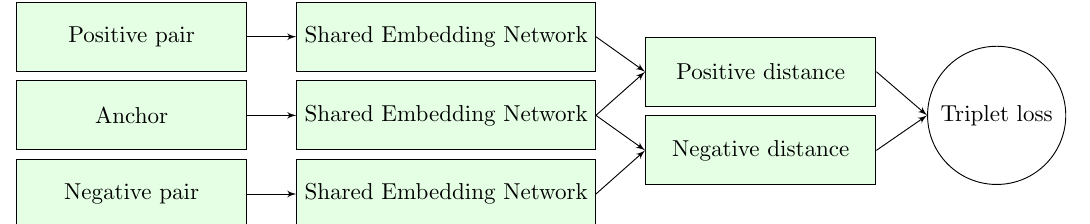
Figure 2. The architecture of a triplet based embedding network. The embedding model is the same between the three samples, the output encoding is used for metric-based